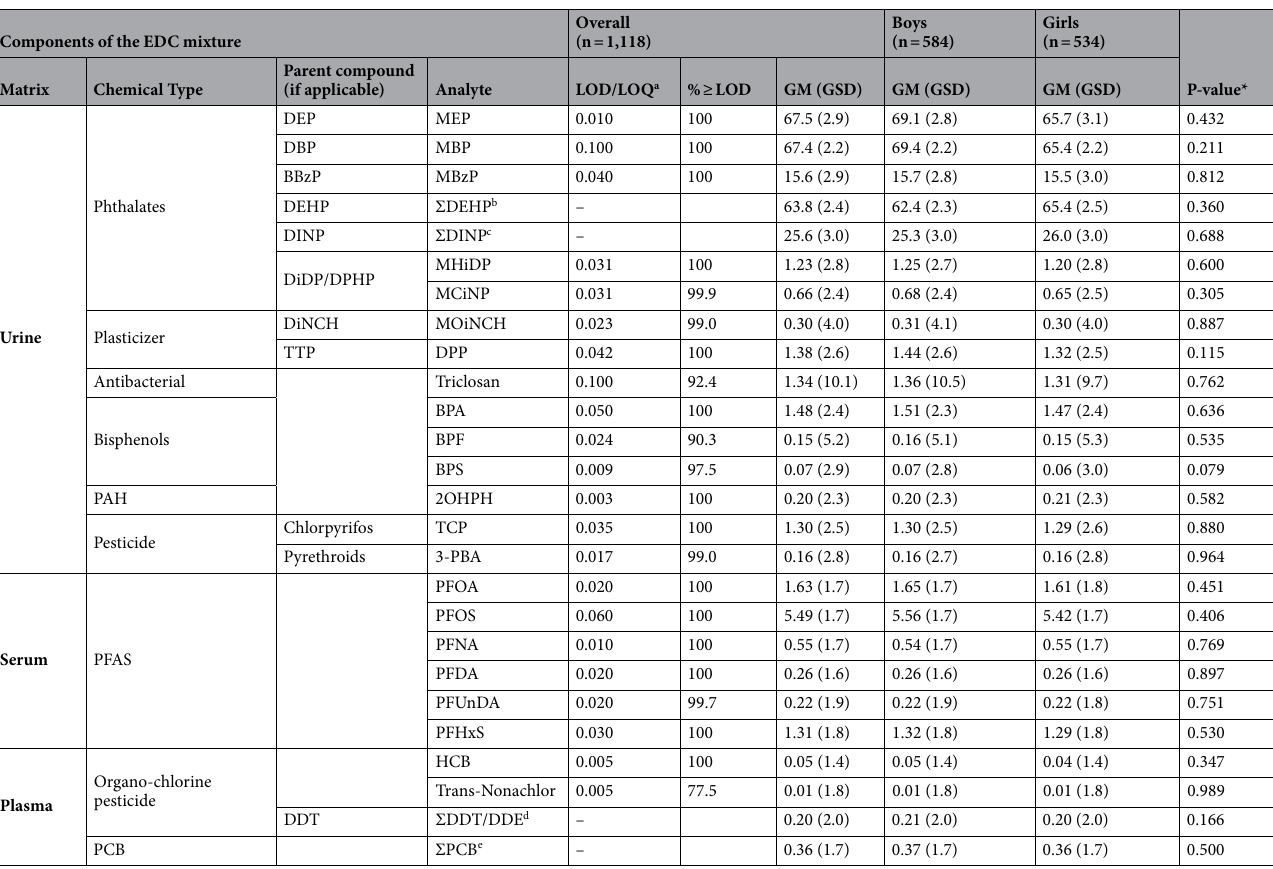
Table 2. Concentrations of 26 compounds (ng/mL) in prenatal urine (not creatine adjusted) and blood samples, overall and by sex, n = 1,118. Abbreviations: GM = Geometric mean, GSD = Geometric standard deviation, LOD = limit of detection, LOQ = limit of quantification. Notes: Values < LOD retained the machine read value for urine and serum compounds, values < LOQ were substituted with LOQ/ 2 for plasma compounds. Further description of each analyte can be found in supplementary table S1. a LOD reported for all urine and serum compounds, LOQ reported for plasma compounds. b Molar sum of metabolites: mono-2-ethylhexyl, mono(2-ethyl-5-hydroxyhexyl), mono(2-ethyl-5-oxohexyl), and mono(2-ethyl-5- carboxypentyl) phthalates. c Molar sum of metabolites: mono(hydroxyisononyl), mono(oxoisononyl), and mono(carboxyisooctyl) phthalates. d Sum of DDT and its metabolite dichlorodiphenyldichloroethylene. e Sum of PCB congeners 74, 99, 118, 138, 153, 156, 170, 180, 183, 187. *P-value from Student t-test comparing metabolite concentrations on the log-scale by sex.